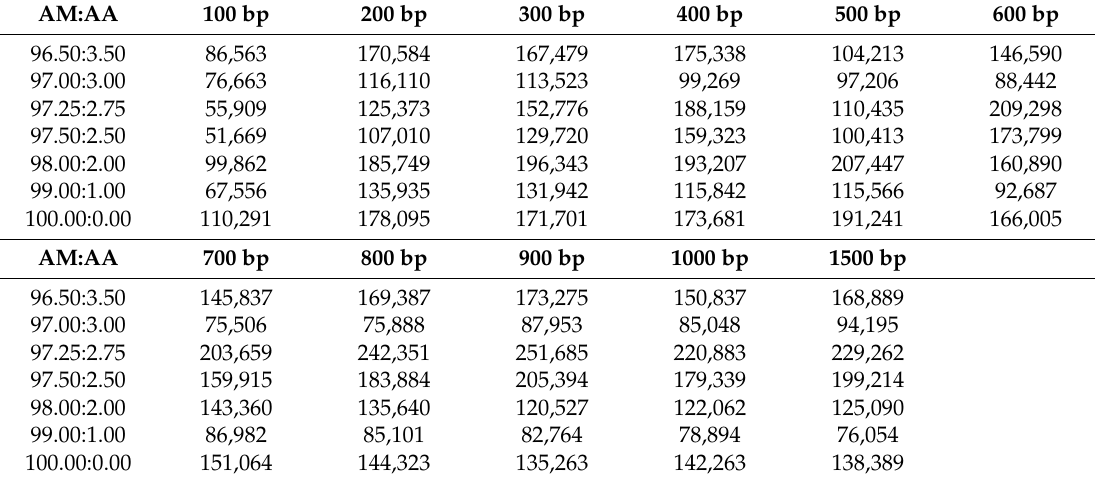
Table 2. Theoretical plate values obtained for DNAs of different sizes for poly(AM- co -AA) coatings with different AA contents.